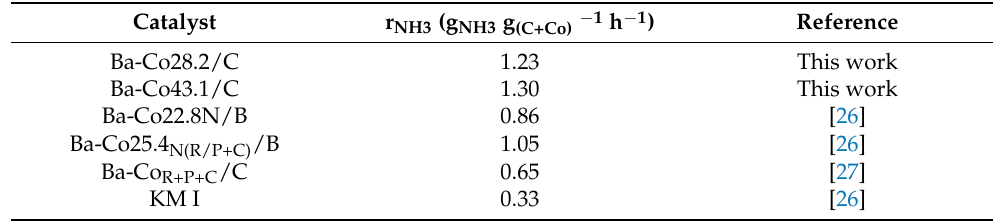
Table 3. The comparison of the reaction rate of ammonia synthesis over the different cobalt catalysts and commercialized iron catalyst (KM I). Reaction conditions: T = 400 ◦ C, p = 9.0 MPa, H 2 + N 2 + NH